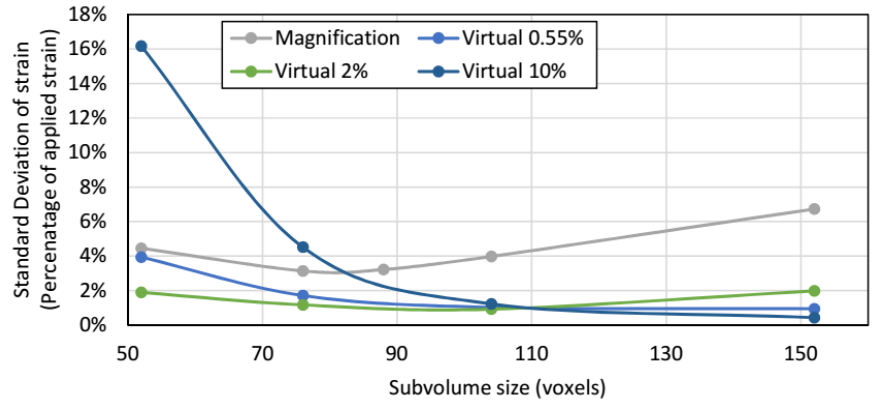
Figure 5. Influence of subvolume size on precision error between virtually strained and magnification change analyses.